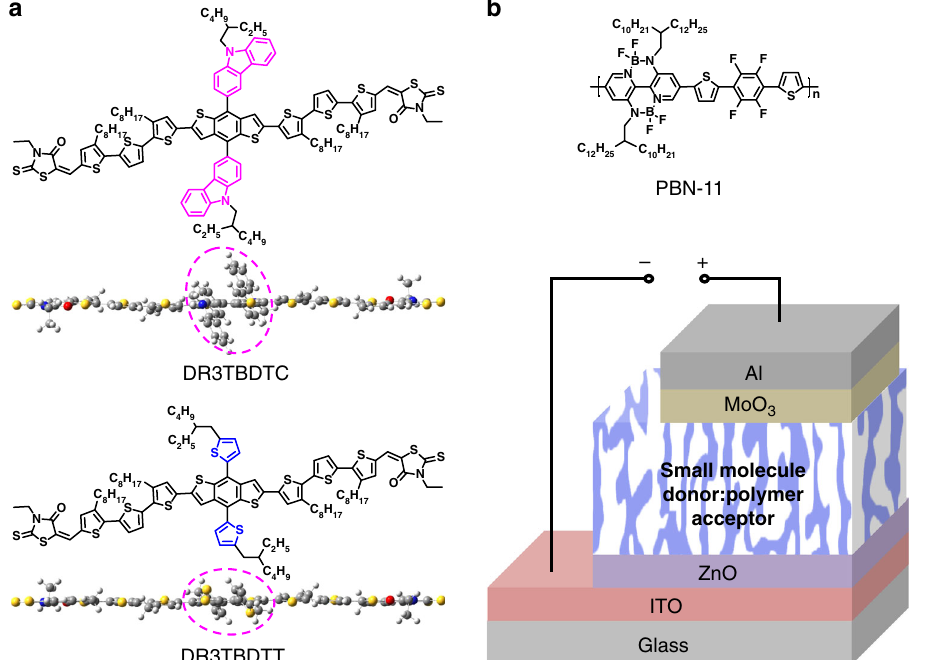
Fig. 1 Photovoltaic materials and device structure of the OSCs. a Chemical structures of small molecule donors DR3TBDTC and DR3TBDTT, and the corresponding front view of the optimized geometries using DFT calculation (B3LYP/6-31G*). b Chemical structure of polymer acceptor PBN-11 and the inverted device